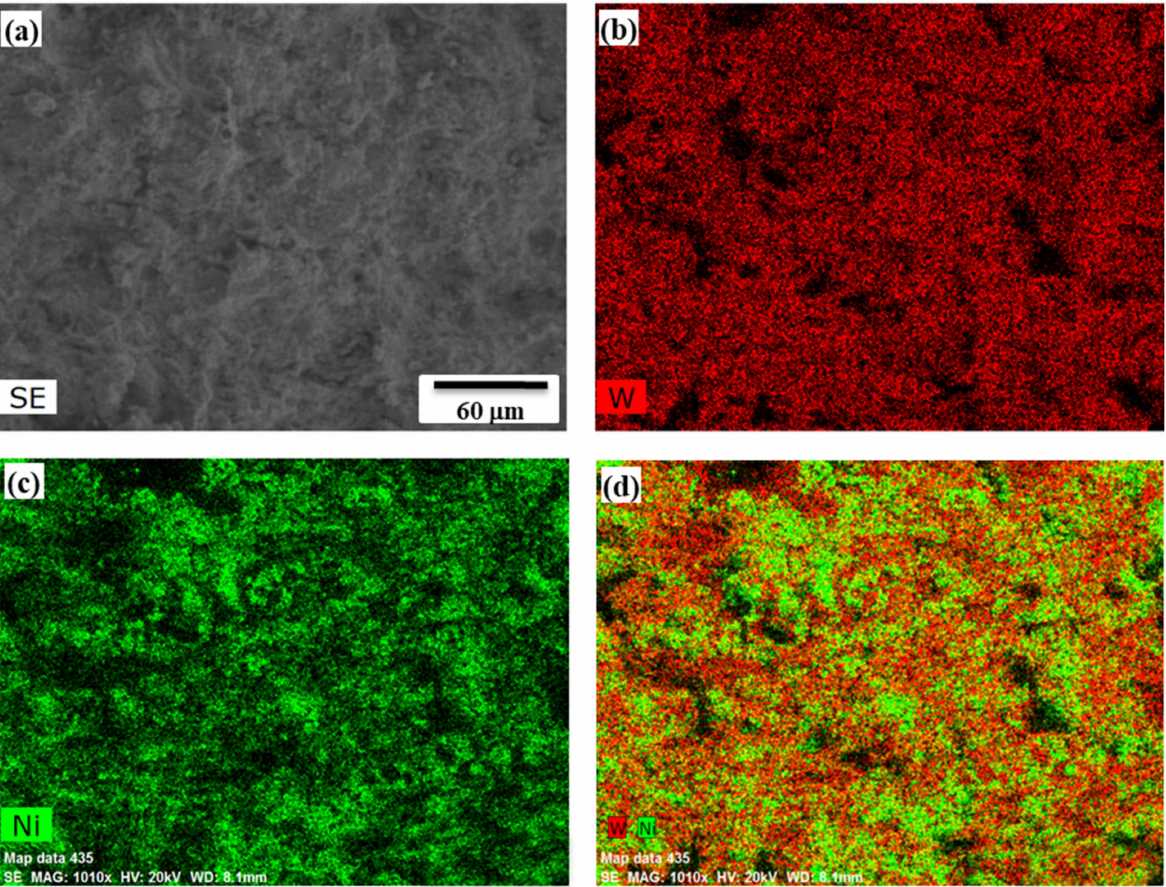
Figure 7. EDS mapping of fracture of the Ni-W SPS-produced sample, 5 min, 1200 ◦ C ( a ), W ( b ), Ni ( c ), W, Ni ( d